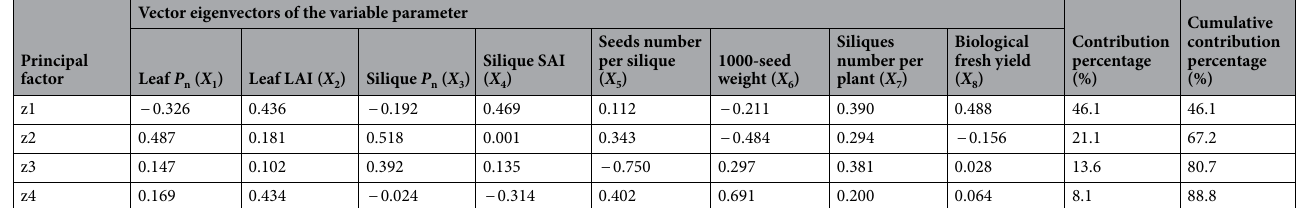
Table 3. The principal factors which mainly influenced seeds yield of rapeseed